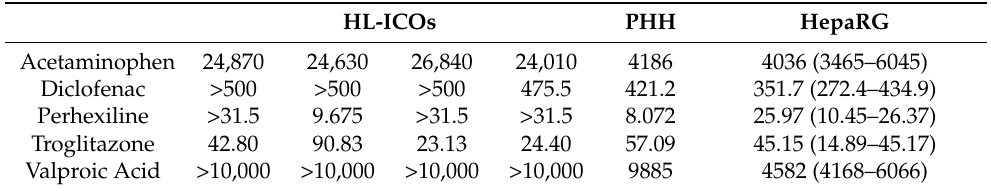
Table 2. Determined EC50 values in HL-ICOs, PHH, and HepaRGs. HL-ICOs PHH HepaRG Acetaminophen 24,870 24,630 26,840 24,010 4186 4036 (3465–6045) Diclofenac >500 >500 >500 475.5 421.2 351.7 (272.4–434.9) Perhexiline >31.5 9.675 >31.5 >31.5 8.072 25.97 (10.45–26.37) Troglitazone 42.80 90.83 23.13 24.40 57.09 45.15 (14.89–45.17) Valproic Acid >10,000 >10,000 >10,000 >10,000